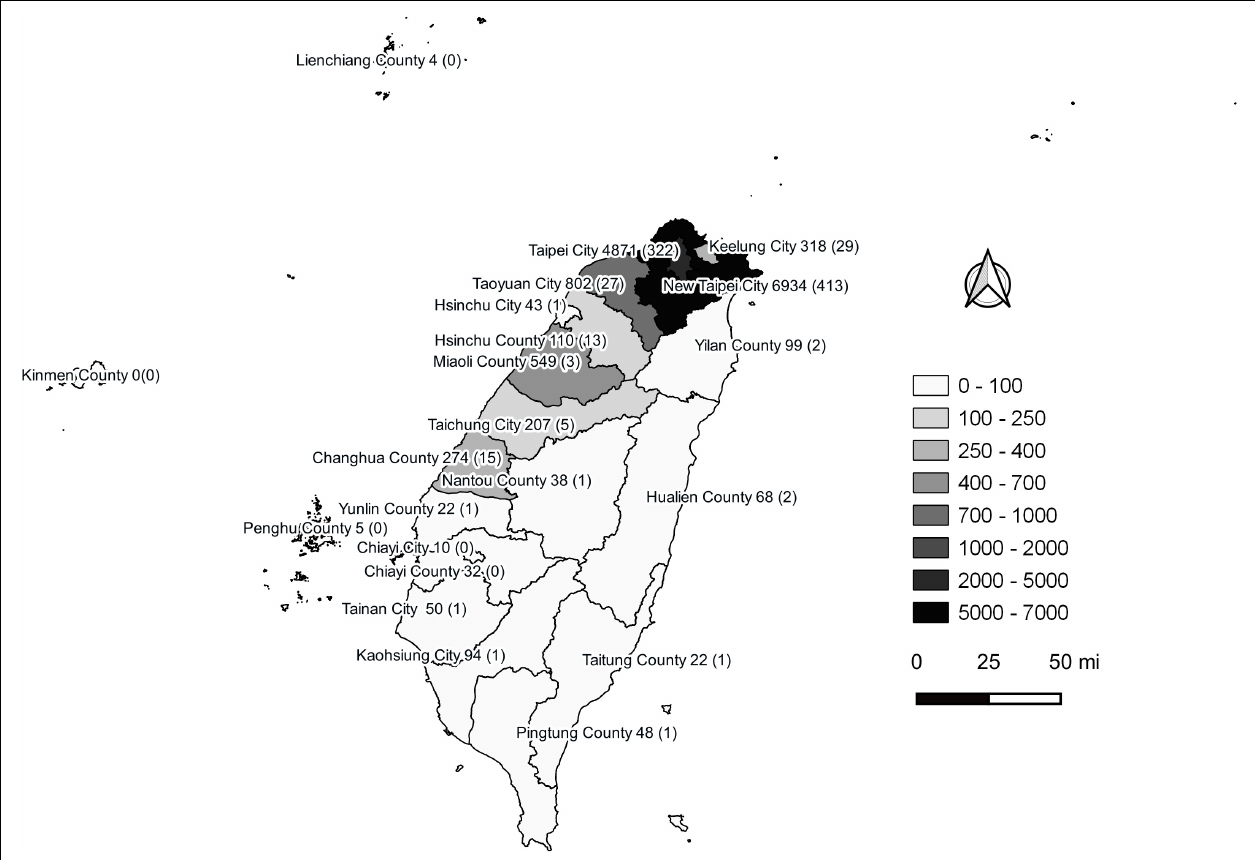
FIGURE 2 | Geographical distribution of autochthonous COVID-19 cases between January 2020 and December 2021 in Taiwan. Confirmed COVID-19 case numbers are shown in each city of the second-level administrative division in Taiwan. The numbers in the brackets are fatal cases. This figure was generated using QGIS v3.16.14 (QGIS Development Team, 2022, QGIS Geographic Information System, Open Source Geospatial Foundation, http://www.qgis.org/). Taiwan map data were retrieved from the Taiwan Geospatial One-Stop Portal developed by the Information Center of the Taiwan Ministry of The Interior and used under the Open Government Data